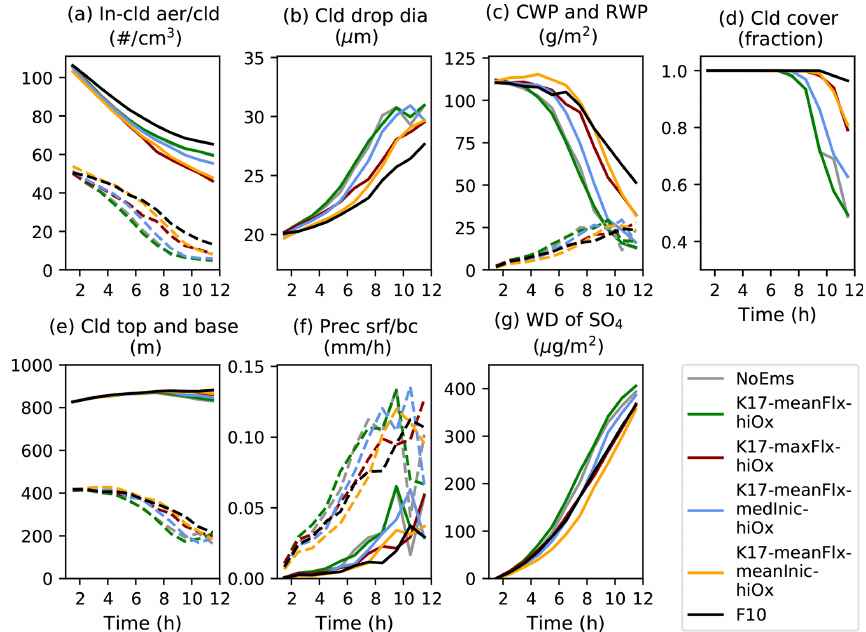
Figure 7. Impact of VOC emissions in high oxidant case. Panels are the same as Fig. 3. Grey – no emission; green – mean fluxes of monoterpenes and isoprene from Kim et al. (2017); dark red – maximum fluxes; blue – initialized with observed median concentrations, mean fluxes emitted; yellow – initialized with mean observed concentrations, mean fluxes emitted; black – base (F10 sea spray, no VOC) for